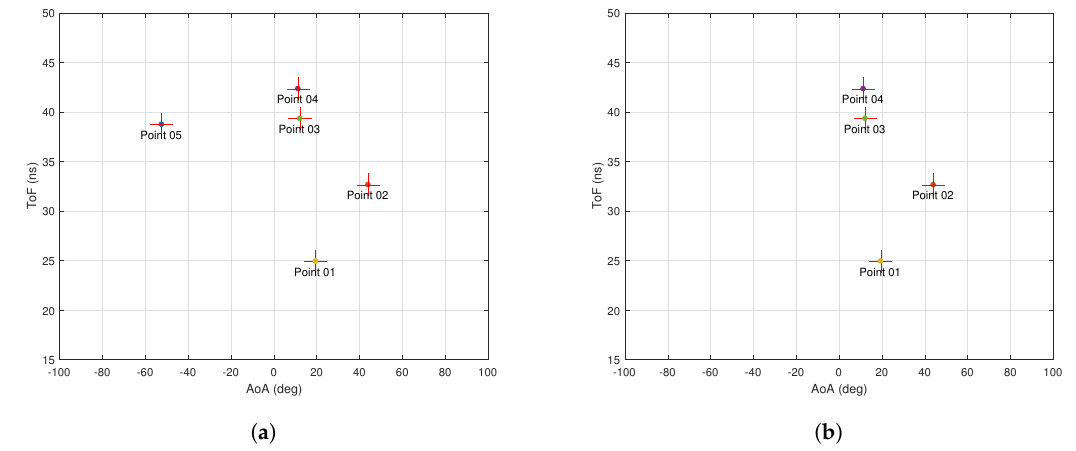
Figure 3. Simulation with no noise. ( a ) performance of MMP with no noise. Simulation time is 0.044 s; ( b ) performance of 2D MUSIC with no noise. Simulation time is 8.66